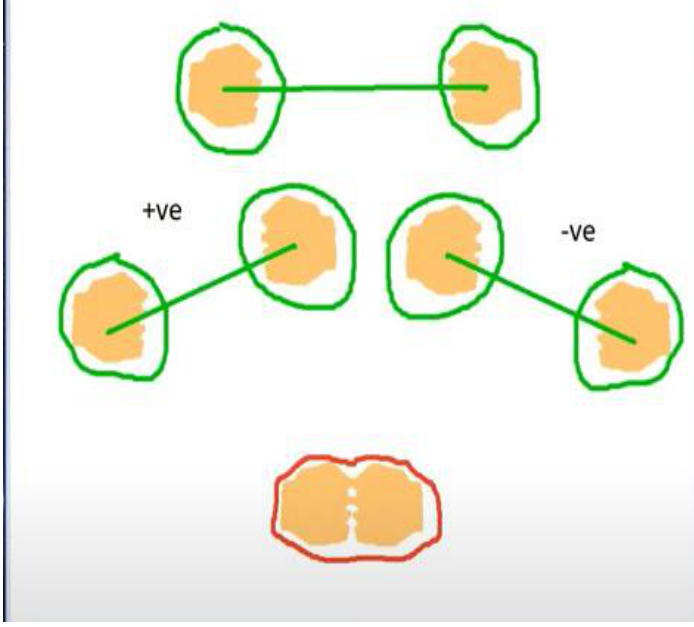
Figure 5 .. Generation of Contours[2] 3.2.2. Hand Position detection. The hand's position is tracked by the pivot region's centre and the hand itself. The direction in which the hand is moved will be determined by dividing the location of the hand centre by the location of the pivot region's centre, i.e., locating the centres of both hands and drawing an imaginary line connecting them and calculating the angle di ff erence using horizontal as a base. The track of the hand movement gesture will be identified using this position